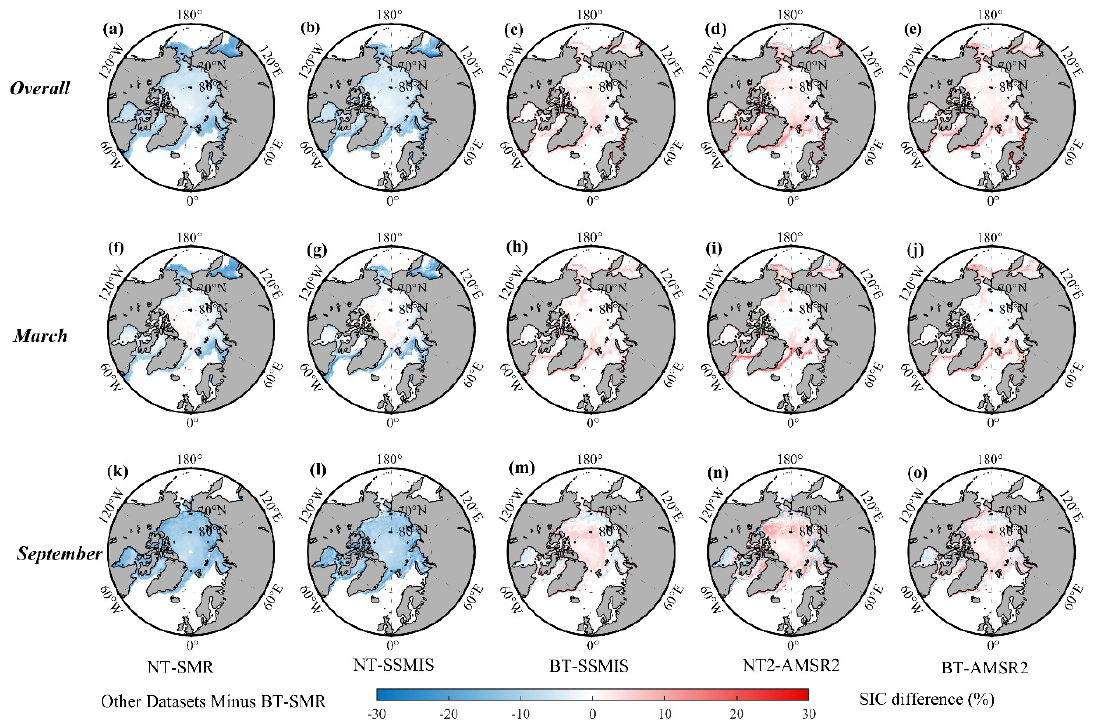
Figure 8. Maps of the overall Arctic difference ( a − e ) between five SIC datasets and BT-SMR from January 2019 to December 2021, as well as the months of March ( f − j ) and September ( k − o ). Grey indicates land, red indicates positive deviations, and blue indicates negative deviations. Table 4. Parameters for assessing Arctic SIC differences between different SIC datasets and BT-SMR. Bias is the mean difference PM SIC minus BT-SMR SIC, and MAE is the mean absolute error. RMSE is the root mean square error, and R 2 is the squared linear correlation coefficient. All concentration values are given as